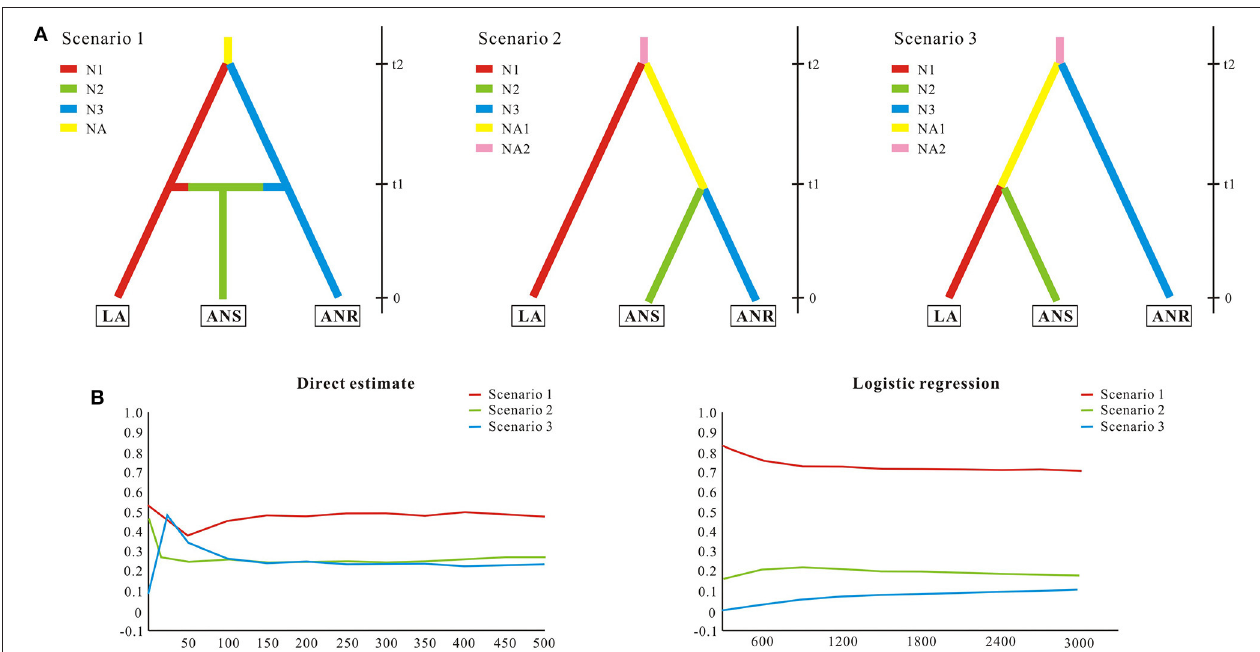
FIGURE 2 | Possible scenarios of Sibiraea population history in the Qinghai-Tibetan Plateau. Approximate Bayesian computation was conducted using DIYABC 2.0.4 to estimate the relative likelihood of scenarios for Sibiraea ’s evolutionary history. (A) Graphs in the upper panel illustrate the proposed scenarios proposed. The Sibiraea populations were assumed to be 3 subpopulations. LA contained S. laevigata populations; ANS contained S. angustata populations that were sympatric with S. laevigata ; ANR contained the remaining S. angustata populations. Colors indicate different (but unknown) population sizes. Zero means sampling time, and t1-t2 refers to relative times of past events that are suggestive of population splitting. (B) Graphs in the lower panel indicate the relative likelihoods of the 3 scenarios compared by direct estimate and logistic